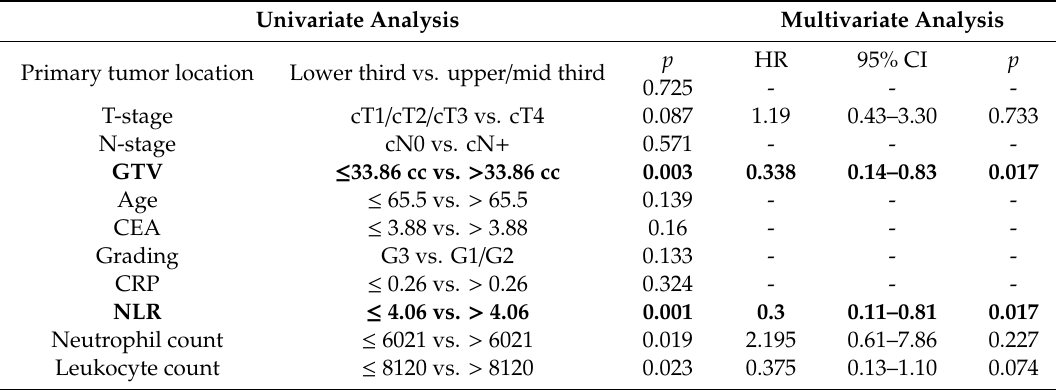
Table 4. Univariate and multivariate analysis for disease-free survival (DFS). Univariate Analysis Multivariate Analysis